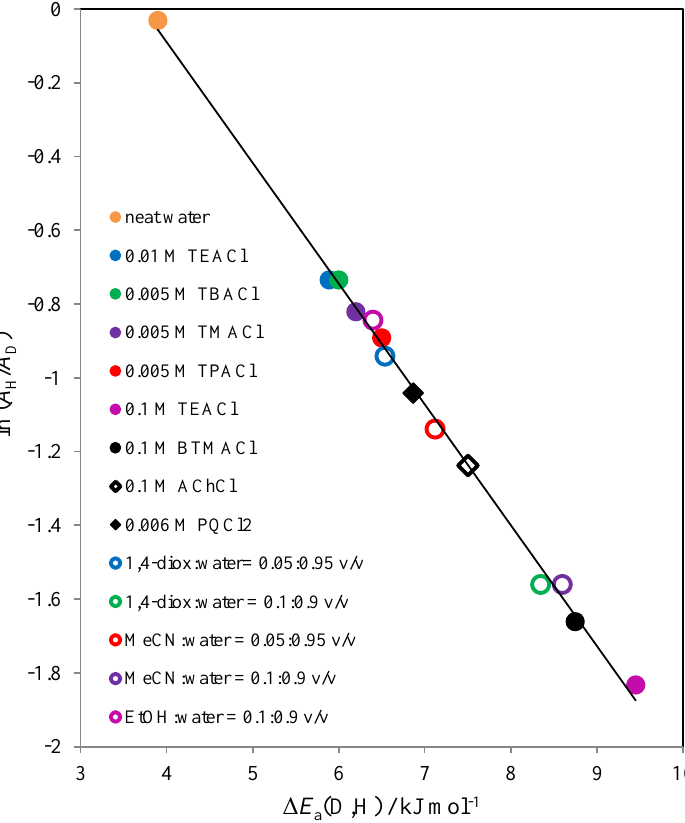
Figure 2. Correlation between ∆ E a (D,H) and ln A H / A D . Abbreviations as noted in [23]. Adapted from [23].